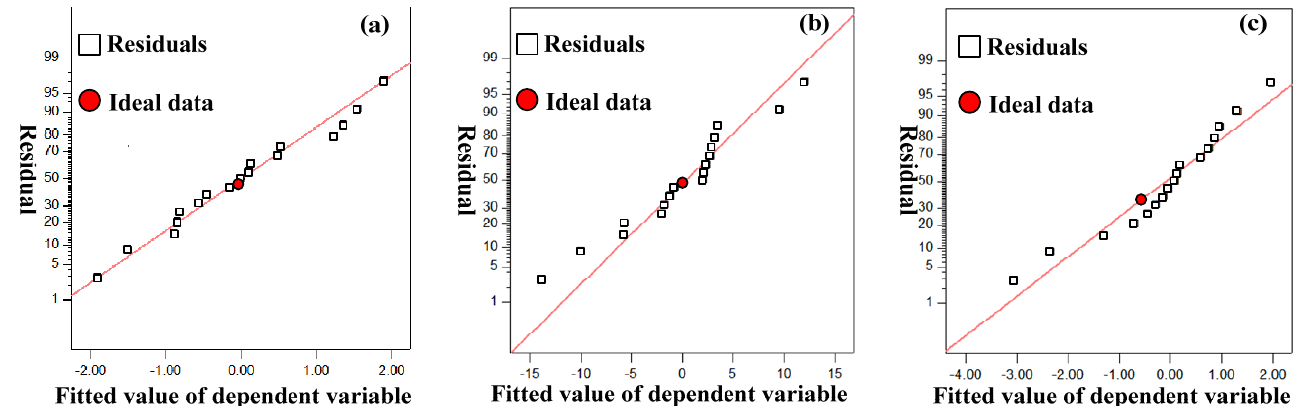
Figure 4. Plots of residuals corresponding to ( a ) macro quality, ( b ) microhardness, and ( c ) average friction coefficient.